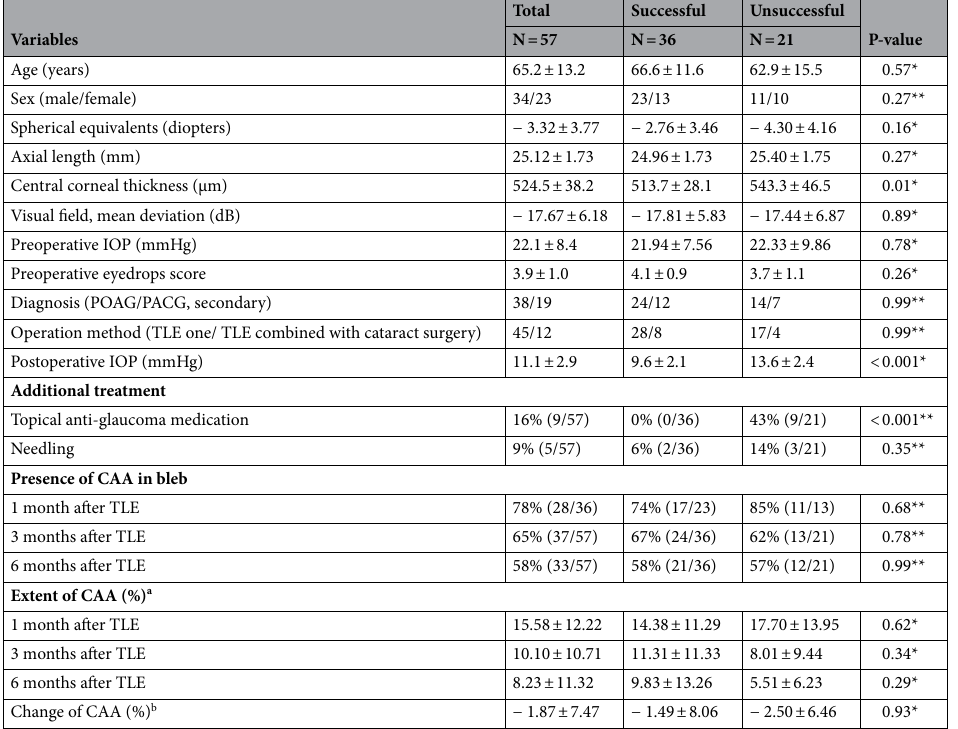
Table 1. Patient characteristics. CAA complete avascular area, IOP intraocular pressure, POAG primary open- angle glaucoma, PACG primary angle closure glaucoma, TLE trabeculectomy. The following statistical tests are conducted to examine differences between the successful and unsuccessful groups: *Wilcoxon rank sum test; **Chi-square test. a The complete avascular area is measured in pixels, divided by 1,048,576 (1024 × 1024) pixels which is the entire imaging area, and converted to percentage. b The change in complete avascular area is calculated by subtracting the extent of the complete avascular area after 3 months from that after 6